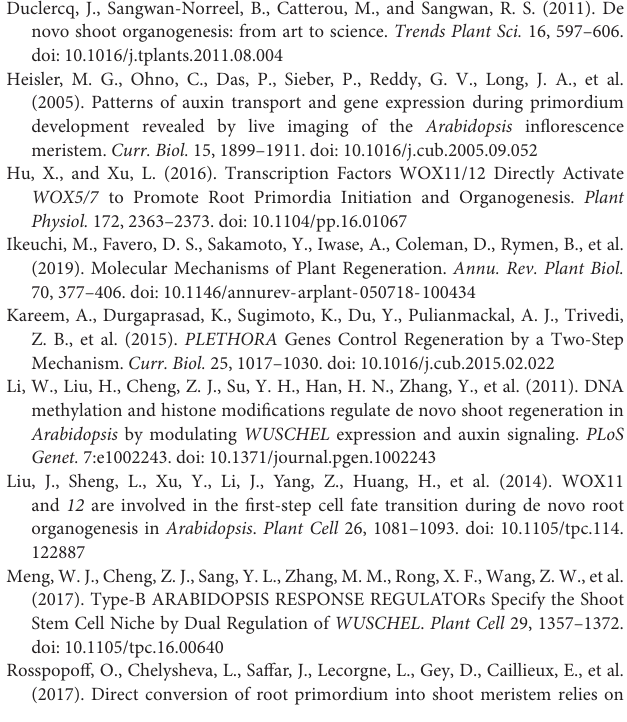
Supplementary Figure 1 | Methylation level in the promoter region of WOX11 via bisulfite sequencing. Cytosine methylation levels in genomic